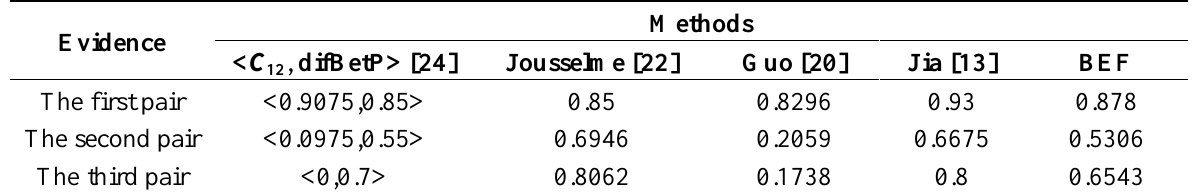
Table 4. Contrast of different dissimilarity measurement methods